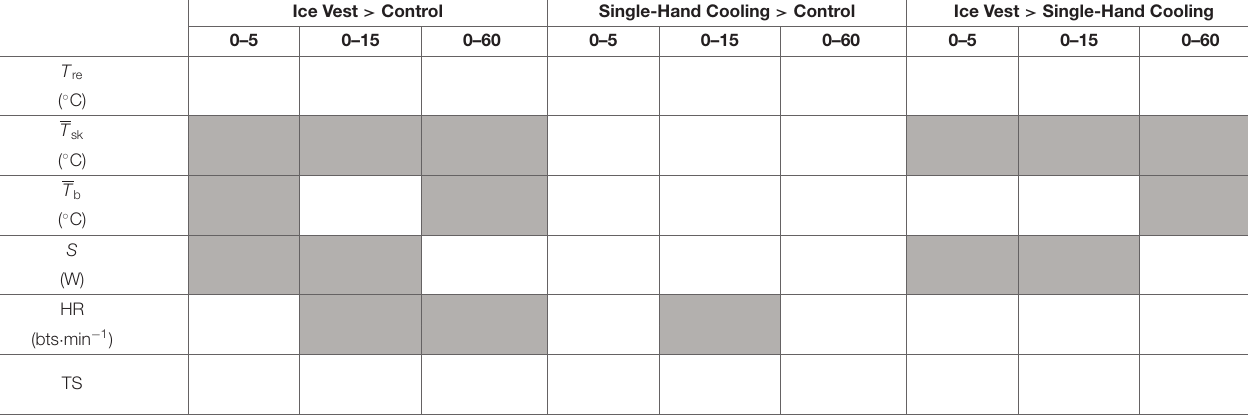
Frontiers in Sports and Active Living |